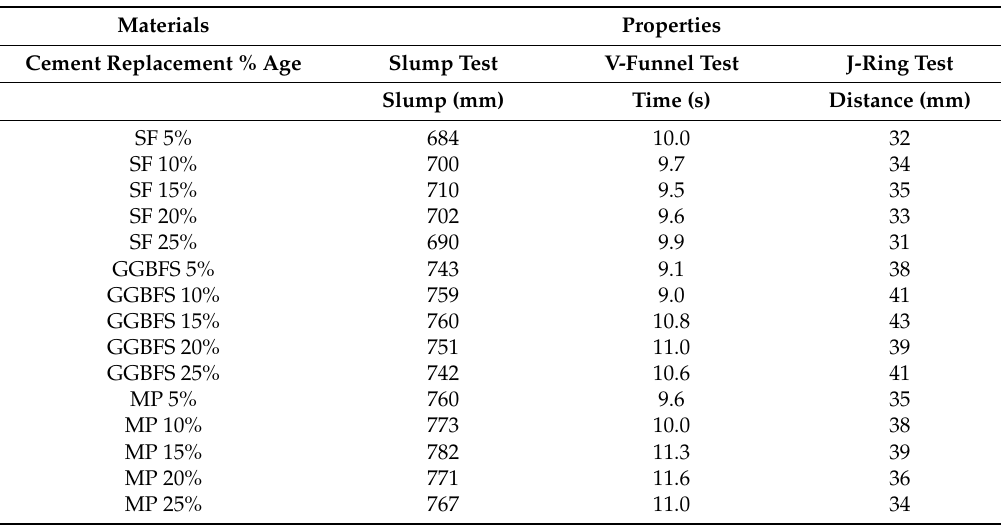
Table 3. Properties of fresh concrete.